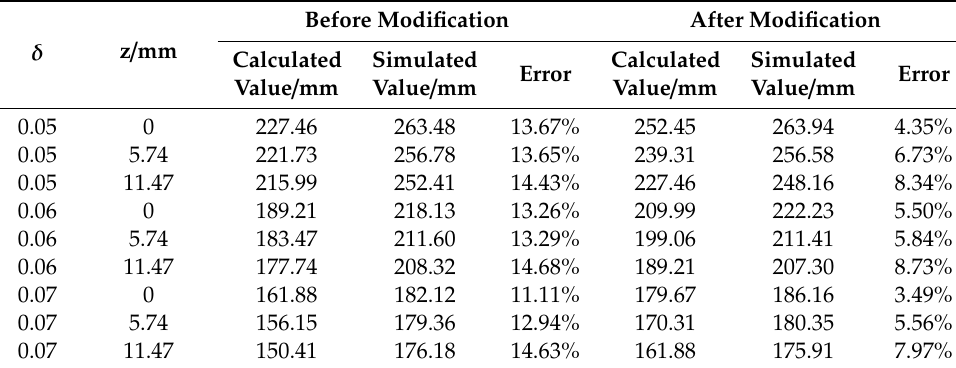
Table 2. Error comparison of longitudinal curvature radius for convex surface.